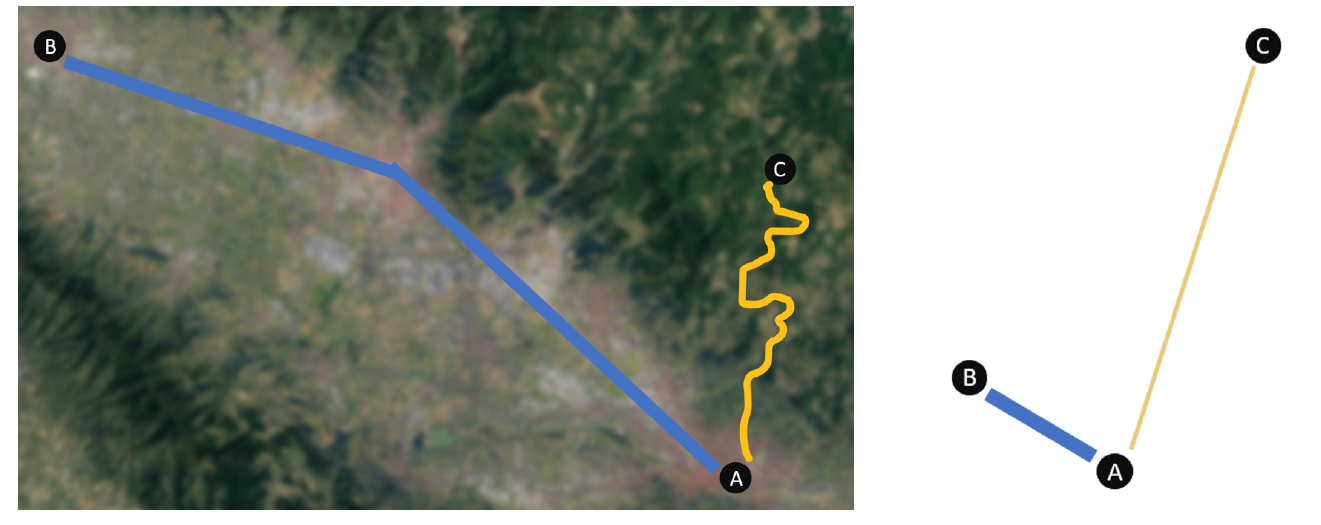
Figure 1. A topographic representation of connections among cities A, B and C (left side) and a topological representation of connections among the same three cities based on strength of connections (right